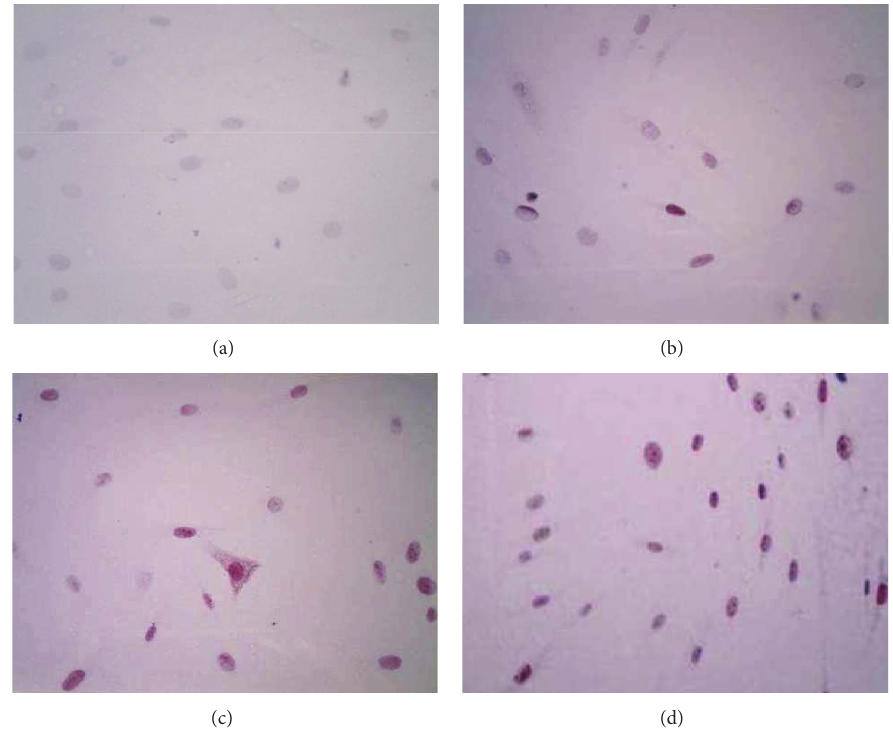
Figure 1: Immunohistochemical detection of PCNA expression in myoblasts after preconditioning with serum starvation ( IHC × 400) . (a), (b), (c), and (d) were from control, laser, 10% FBS, and 20% FBS group, respectively, the grouping as described above. There was obvious difference in the levels of PCNA expression between each